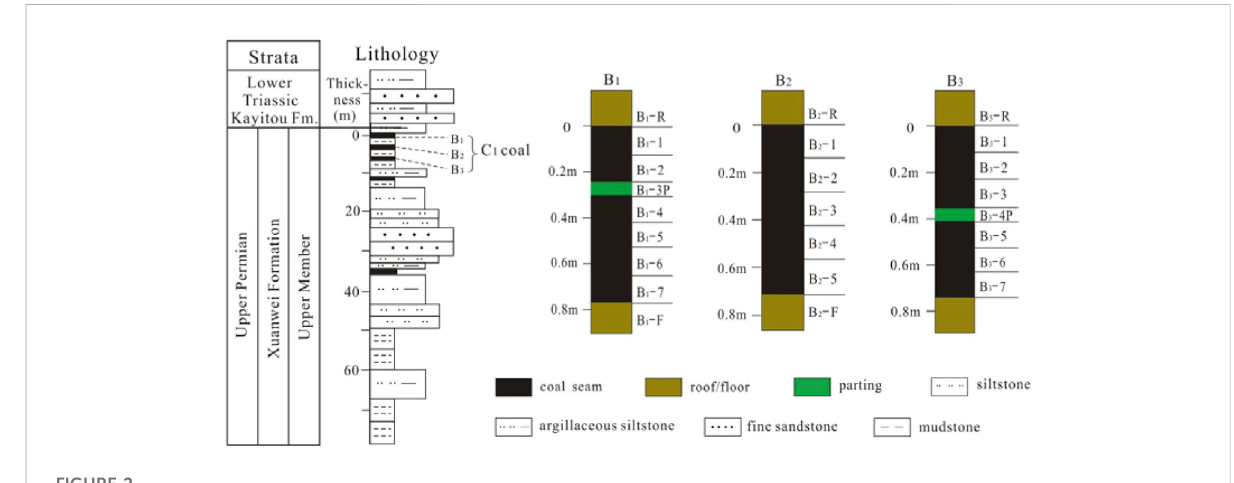
FIGURE 2 The stratigraphic section of mineable coal seam and sampling horizons of the Yantang Mine.